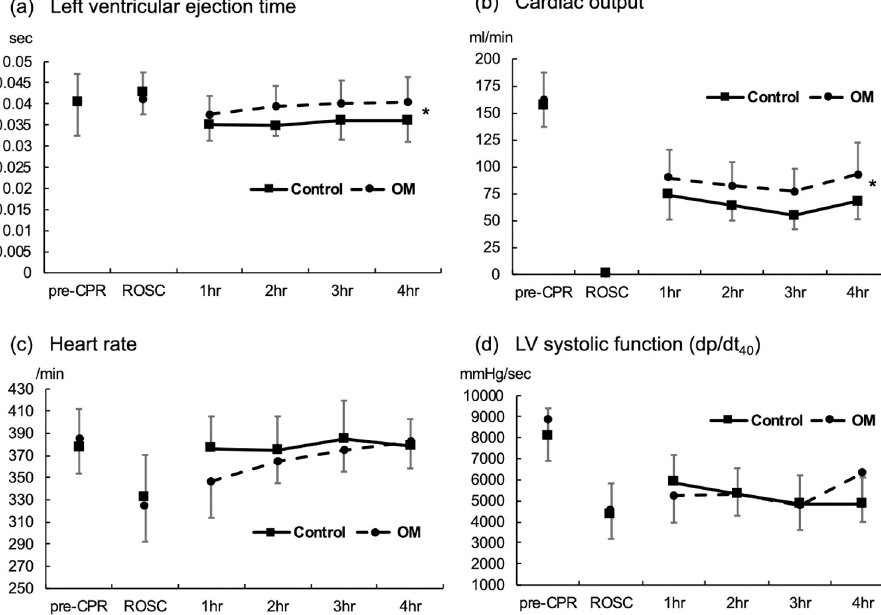
Fig 2. Hemodynamic parameters of control and OM groups following cardiac arrest and resuscitation. (a) Left ventricular ejection time. (b) Cardiac output. (c) Heart rate. (d) Left ventricular systolic function represented by dp/ dt 40 . (n = 20 in each group, � : P < 0.05 between two groups by mixed linear model analysis).